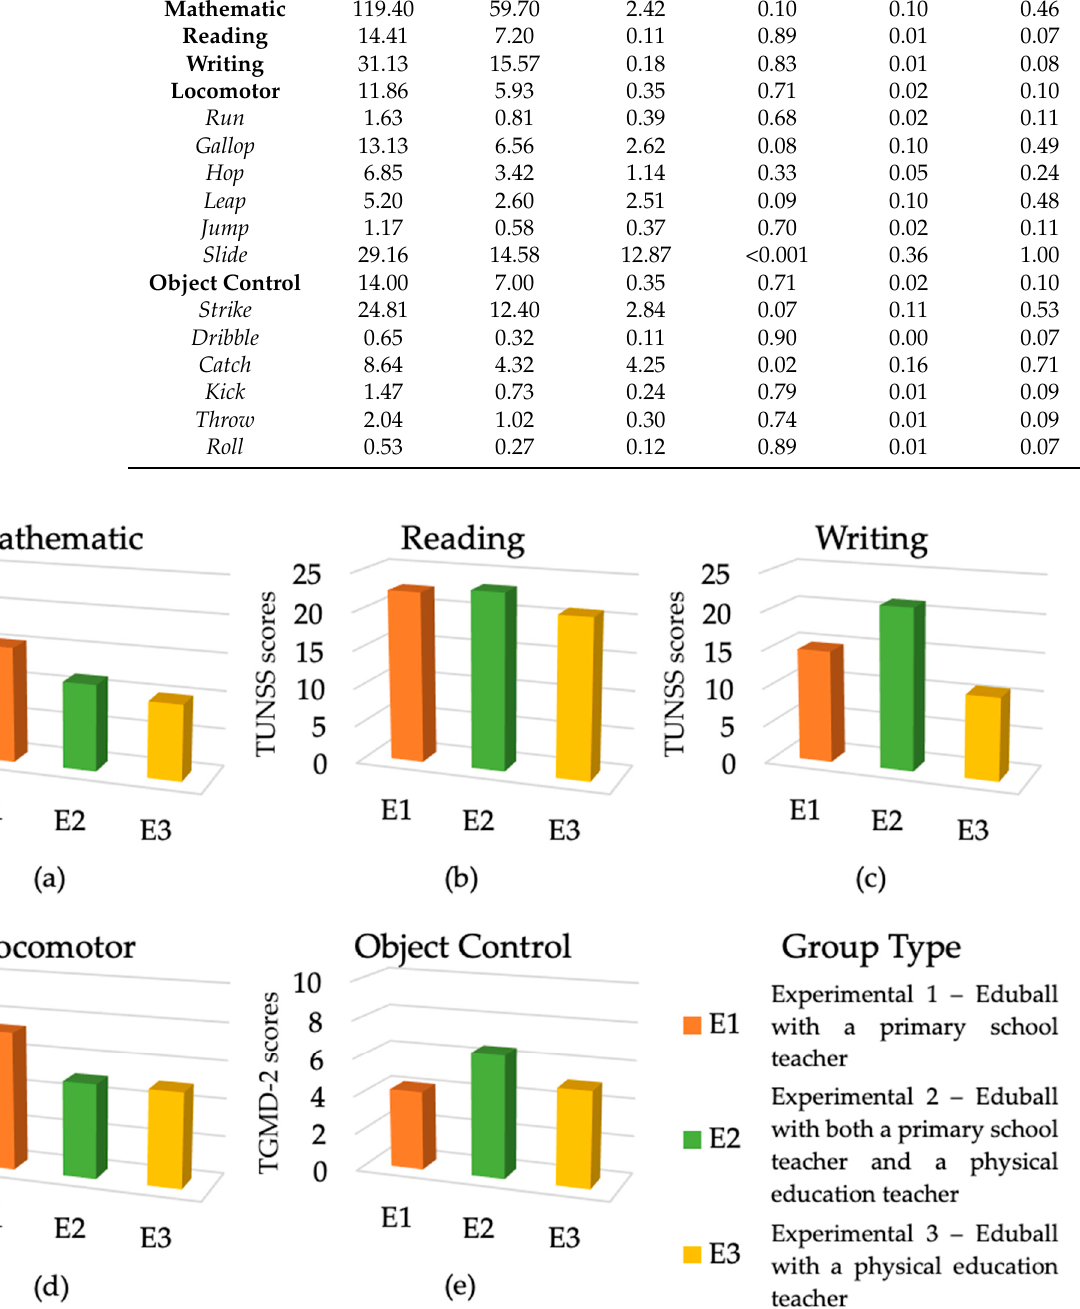
Table 3. Analysis of covariance (ANCOVA) for the cognitive and motor skills by group condition (Experimental 1 vs. Experimental 2 vs. Experimental 3). The pre-test was set as the covariate. Skills SS SM Mathematic